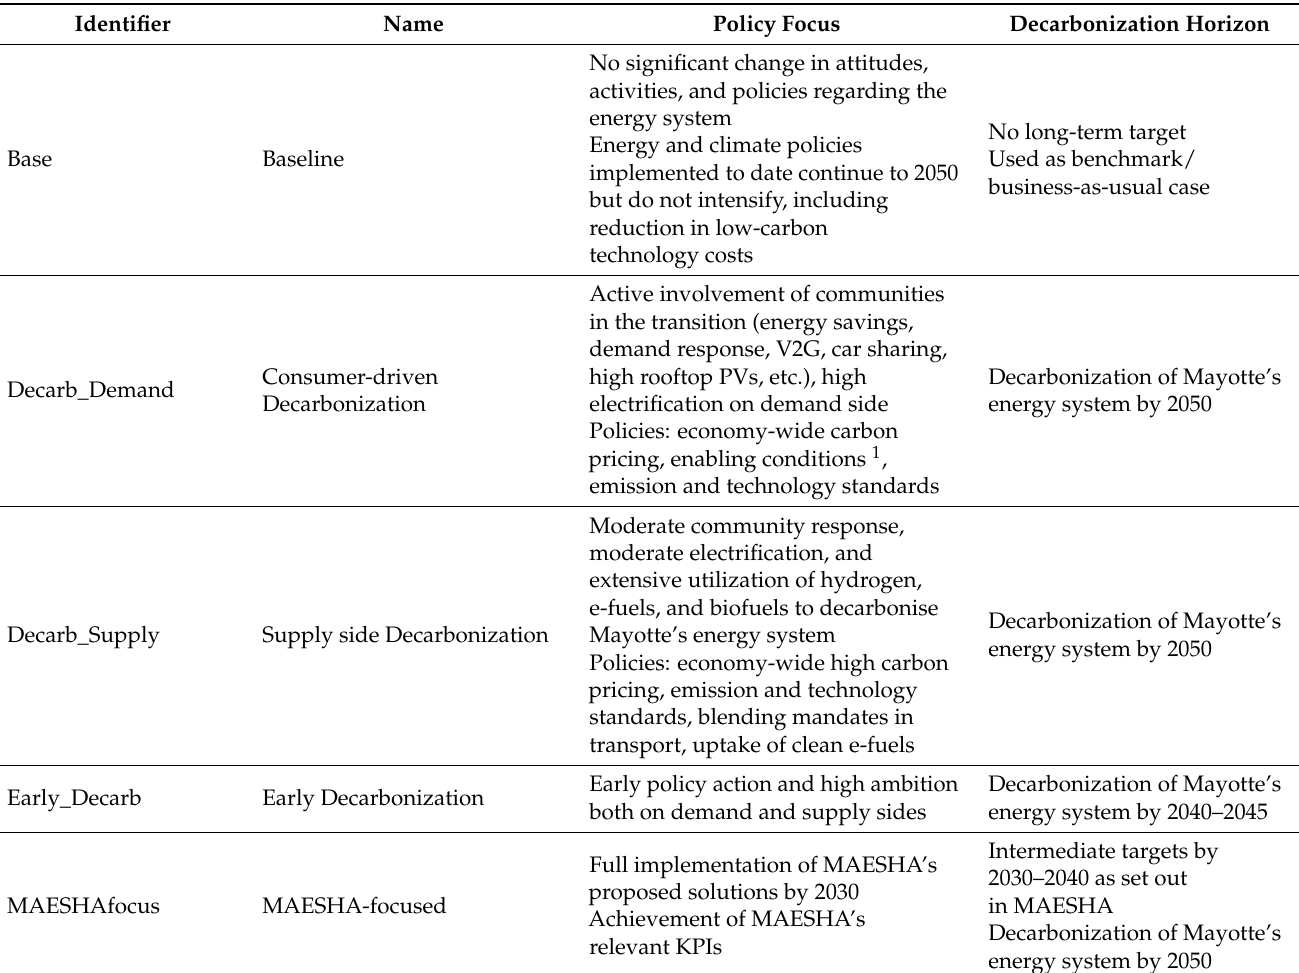
Table 1. An overview of the five co-designed decarbonization scenarios for the non-interconnected island of Mayotte